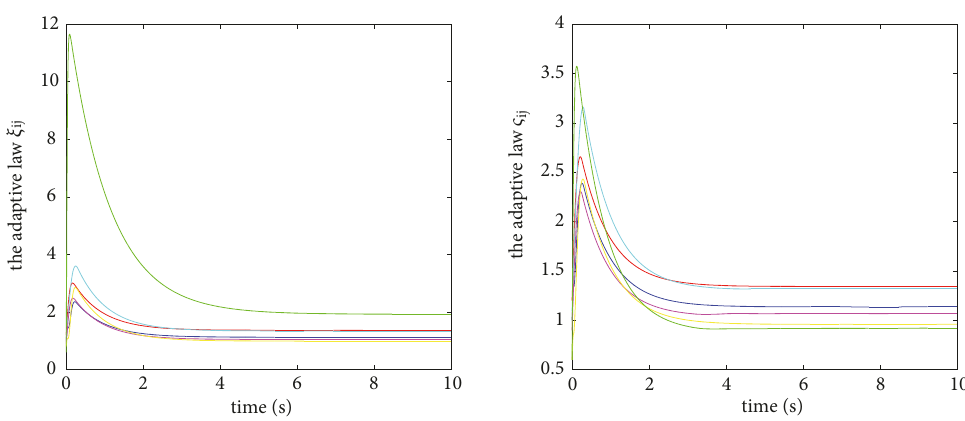
Figure 3: The adaptive law under the edge-based algorithm.